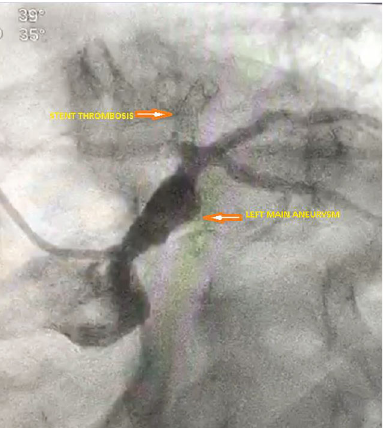
Figure 2: Initial coronary angiogram showing left main coronary aneurysm and stent thrombosis.